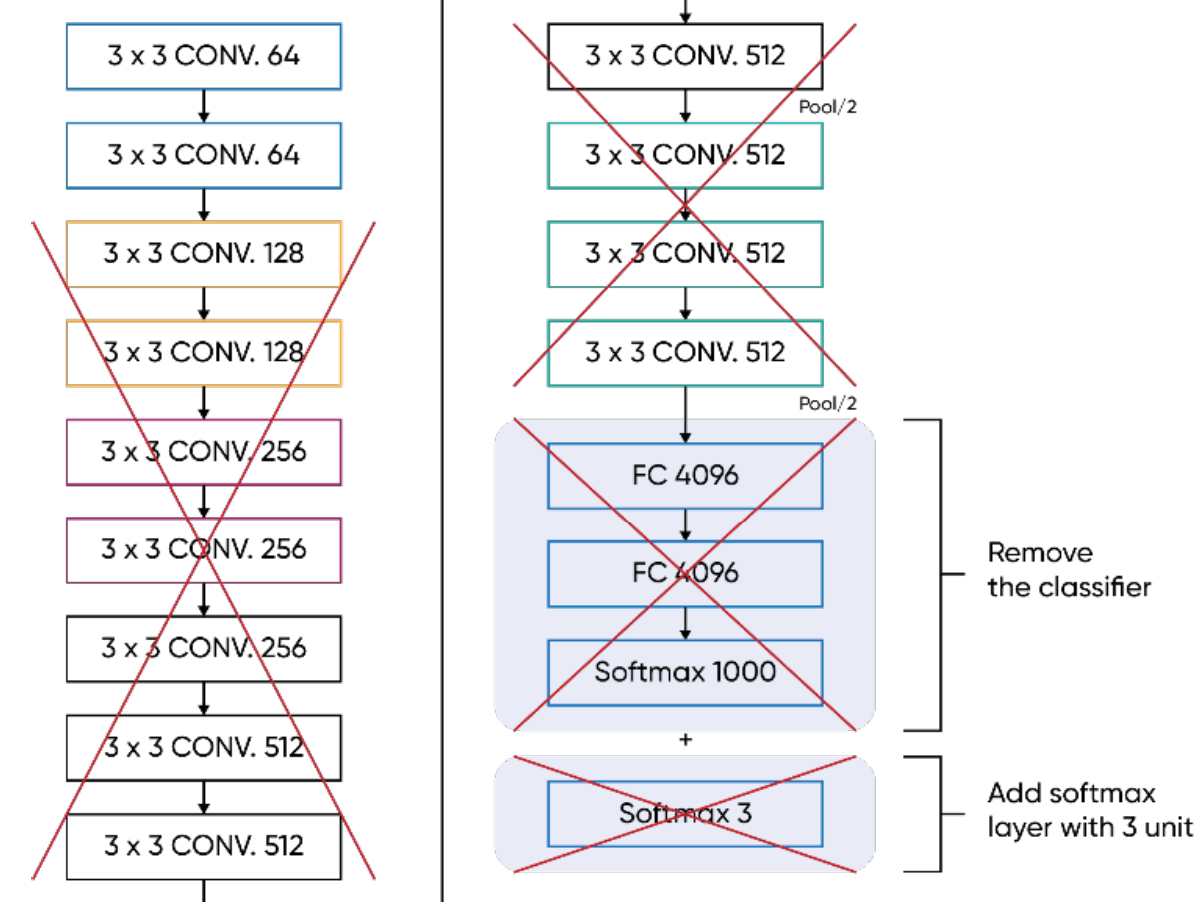
Figure 8. General architecture of cloud empowered data centric system.